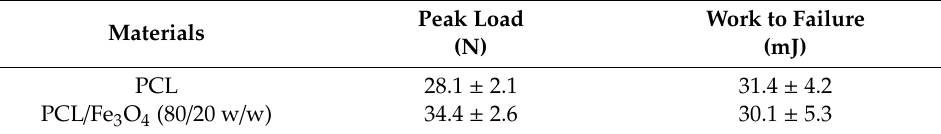
Table 1. Results from small punch tests: peak load and work to